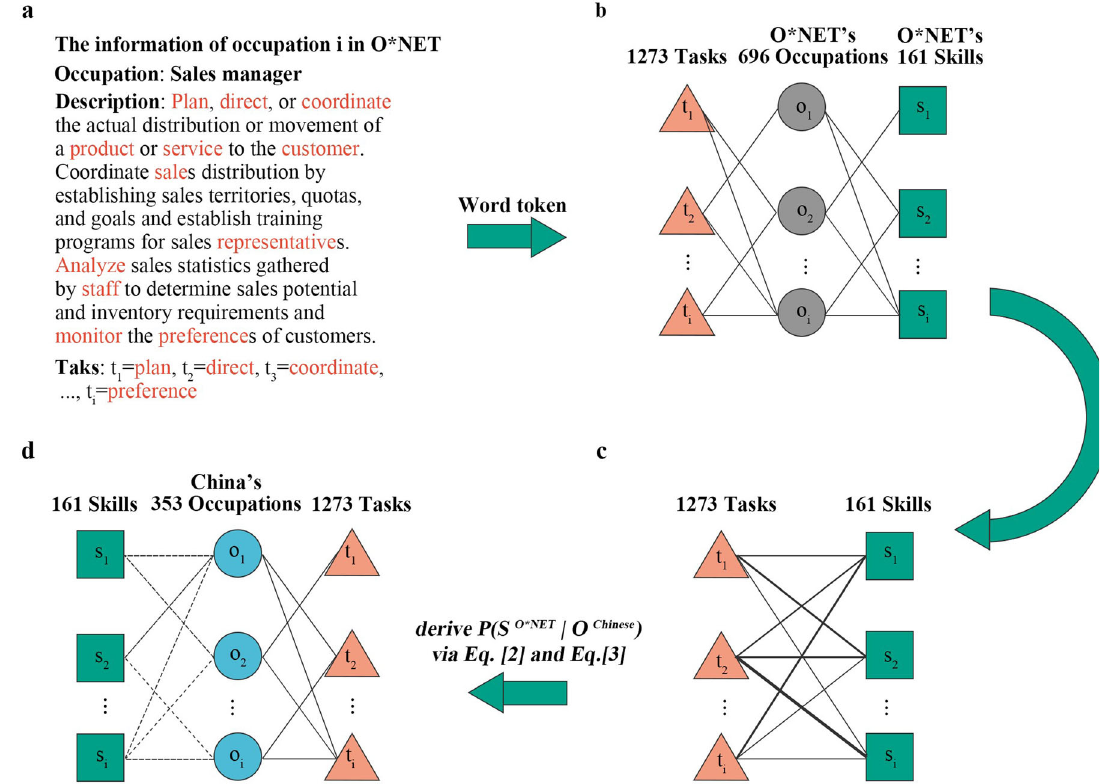
Fig. 2 The work fl ow of building China ’ s fi rst workforce skill taxonomy. a Sales manager job descriptions in O*NET. We derive tasks by extracting word tokens from the job descriptions that are highlighted in red. All tasks can be found in Table. S1. b A tripartite network links O*NET 1273 tasks, 161 skills and 696 occupations. c The relationships between tasks and O*NET skills, represented by the conditional probability of whether or not a particular task t i would exist given a set of skills s O*NET ) Deriving the relationships between O*NET skills and Chinese occupations by using Naïve Bayesian